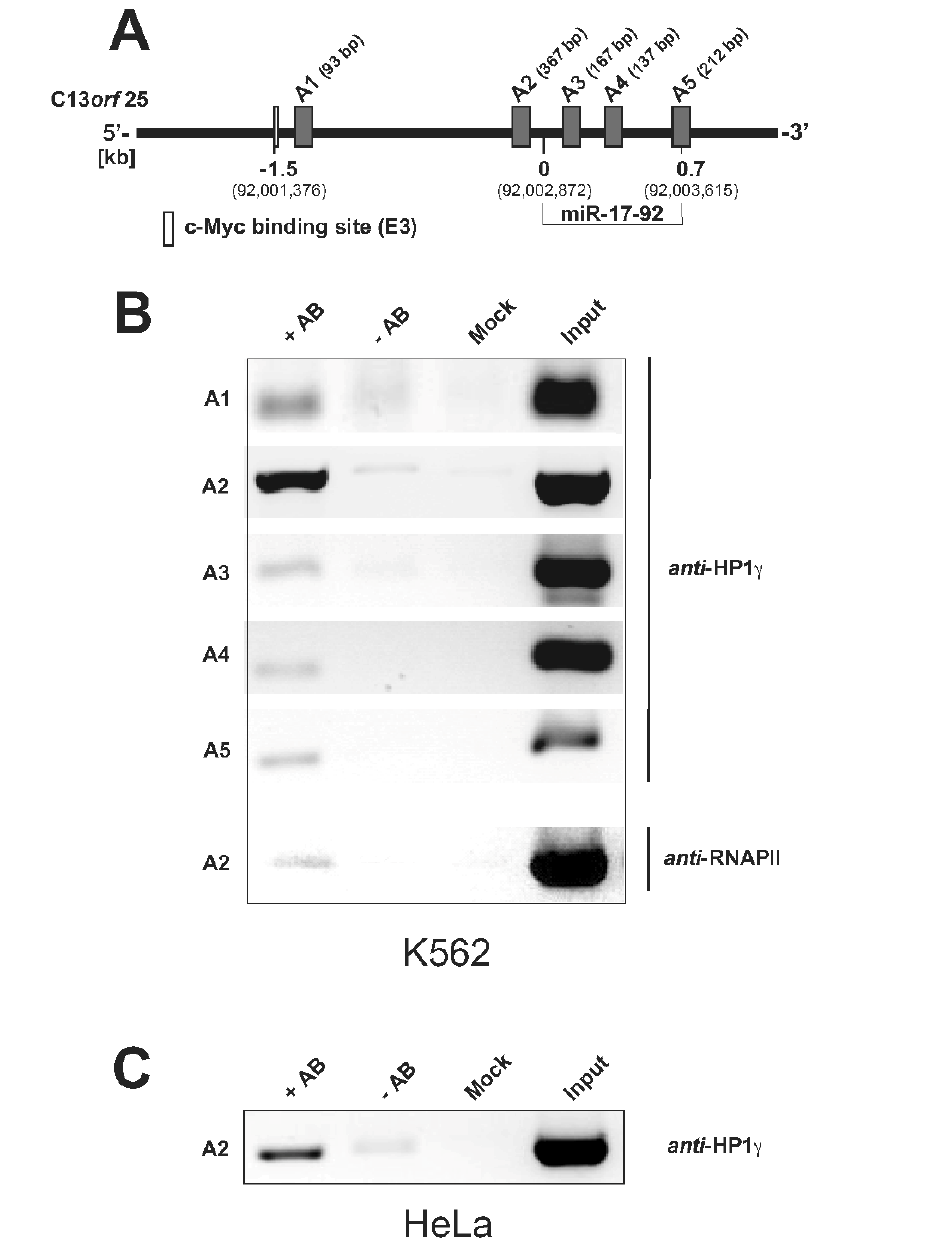
Figure S3. ( A ) Schematic representation of the intronic A/T-rich region preceding the miR-17-92 coding sequence. The region A1 defines the genomic sequence 0.1 kb downstream of the functional c-Myc binding site (E3 box) that was amplified in ChIP analyses. A2 covers a segment immediately upstream of the miRNA-coding region; A3–A5 are located along the coding sequence of the human miR-17-92 cluster. The length (bp) of each amplicon is indicated at the top; ( B ) ChIP analysis of the regions A1 to A5 in K562 cells, using an antibody specific for HP1 γ or RNA polymerase II (only A2 analyzed). +AB, with antibody; − AB, without antibody; Mock, buffer only without cell lysate; Input, supernatant of the “ − AB” sample after immunoprecipitation and centrifugation (for details, see Supplementary Material); ( C ) ChIP analysis of the A2 region in HeLa cells using the antibody specific for HP1 γ